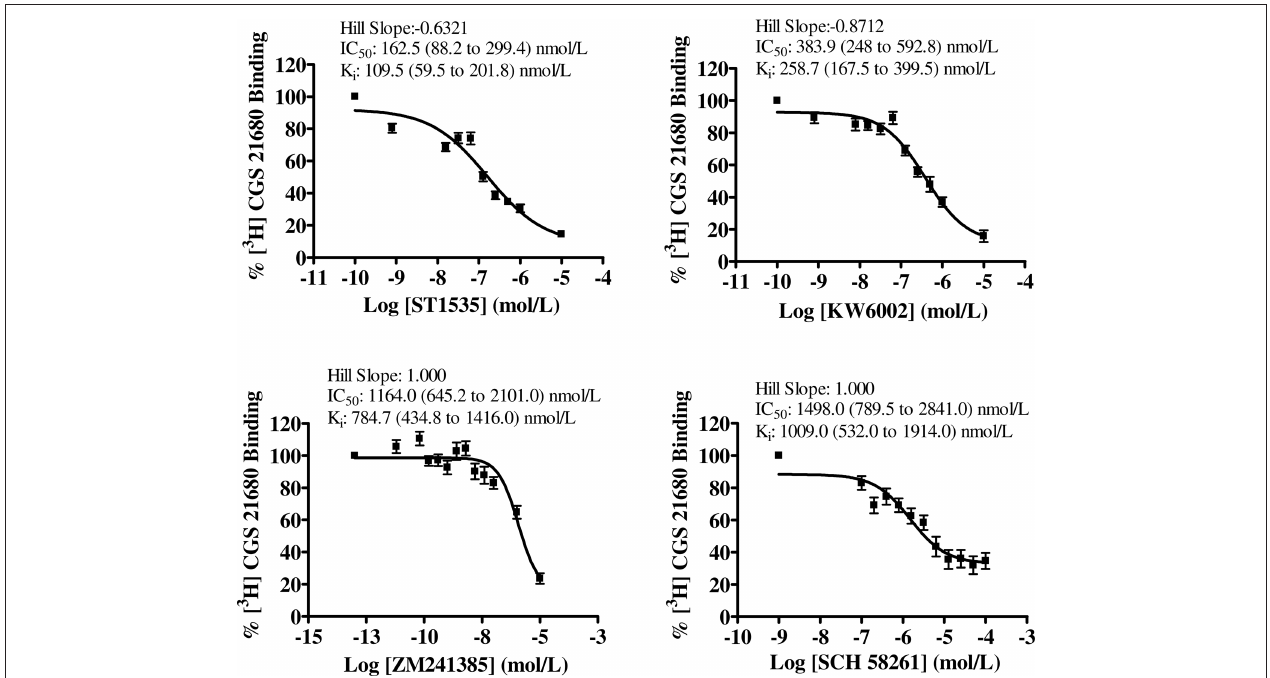
concentrations of compounds. Non-specific binding was determined with 100 μM 2-chloroadenosine. Curves were obtained from four independent experiments performed in duplicate. Values in brackets represent 95% confidence intervals.